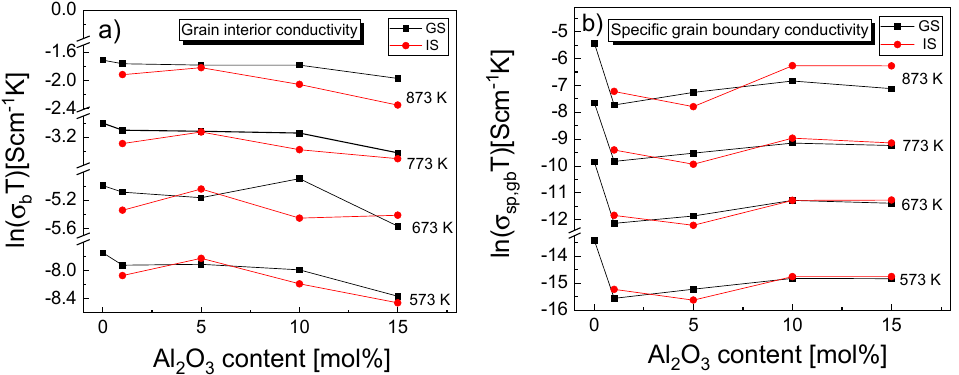
Figure 9. Dependence of the ( a ) grain interior electrical conductivity and ( b ) specific grain boundary electrical conductivity on alumina content in samples, as determined for 573, 673, 773 and 873 K. The grain interior electrical conductivity ( σ b ) for samples GS-1 to GS-10 remained at a nearly constant level and then dropped sharply as the alumina content reached 15 mol% (GS-15). The only exception was an increase in the σ b component of conductivity for the GS-10 sample, observed at 673 K. For the IS sinters, σ b increased when going from 1 mol% of Al 2 O 3 to 5 mol% and then dropped as alumina content increased further, with a very slight exception again observed for the sample with 10 mol% and the temperature of 673 K (Figure 9a).